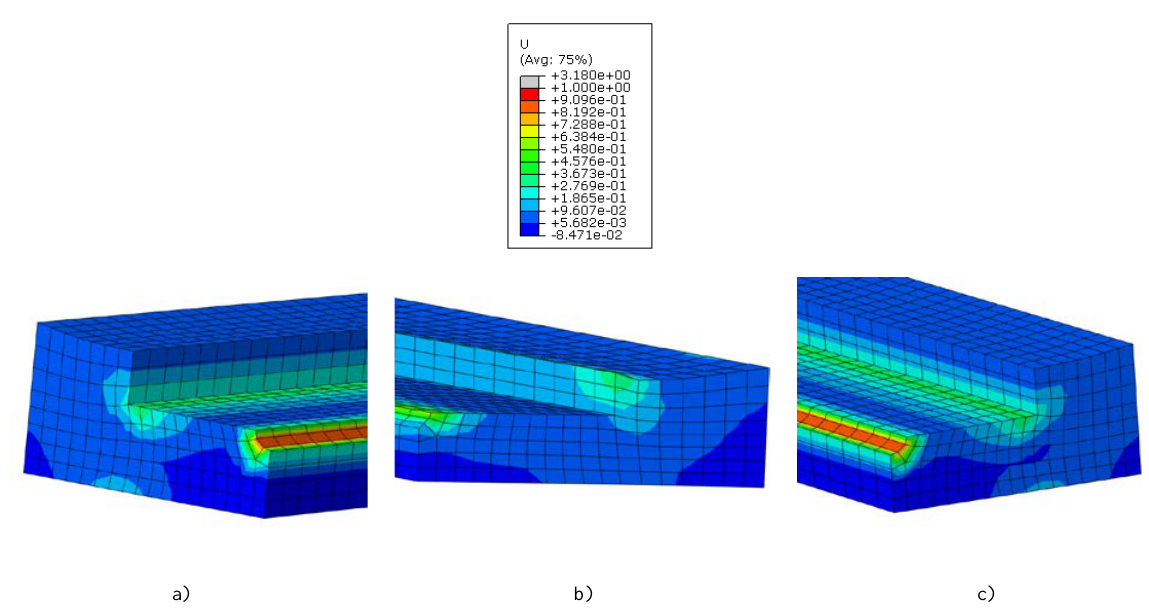
Fig. 8 distribution of the strain energy density for cross-section of the long edge (a)), the bisection of the corner (b)) and the short edge (c)); Load- Case 2, 80 C; (deformation scaled by factor 2); [J/mm 3